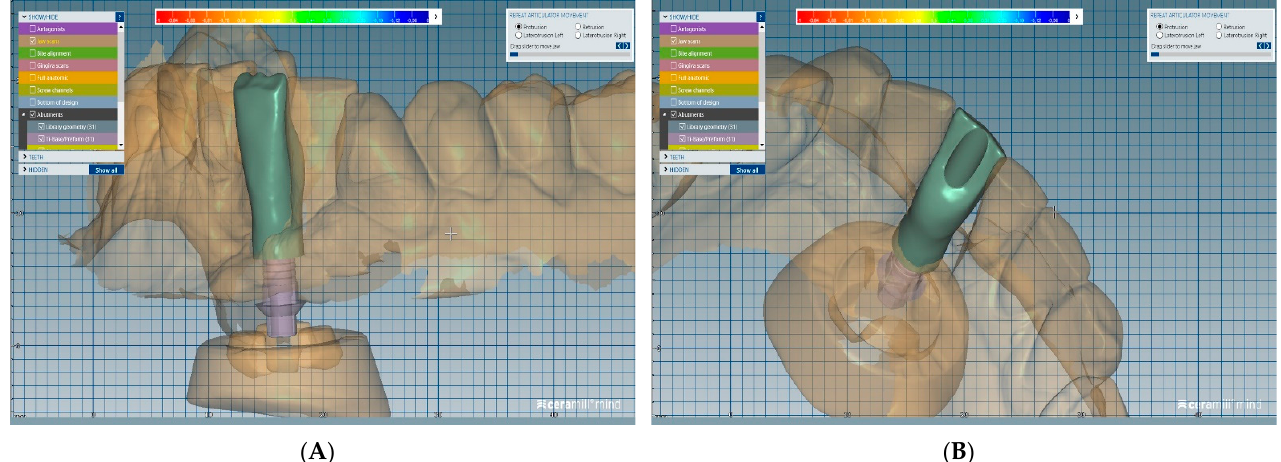
Figure 8. Final designs of the crown: ( A ) frontal view; ( B ) lingual view.